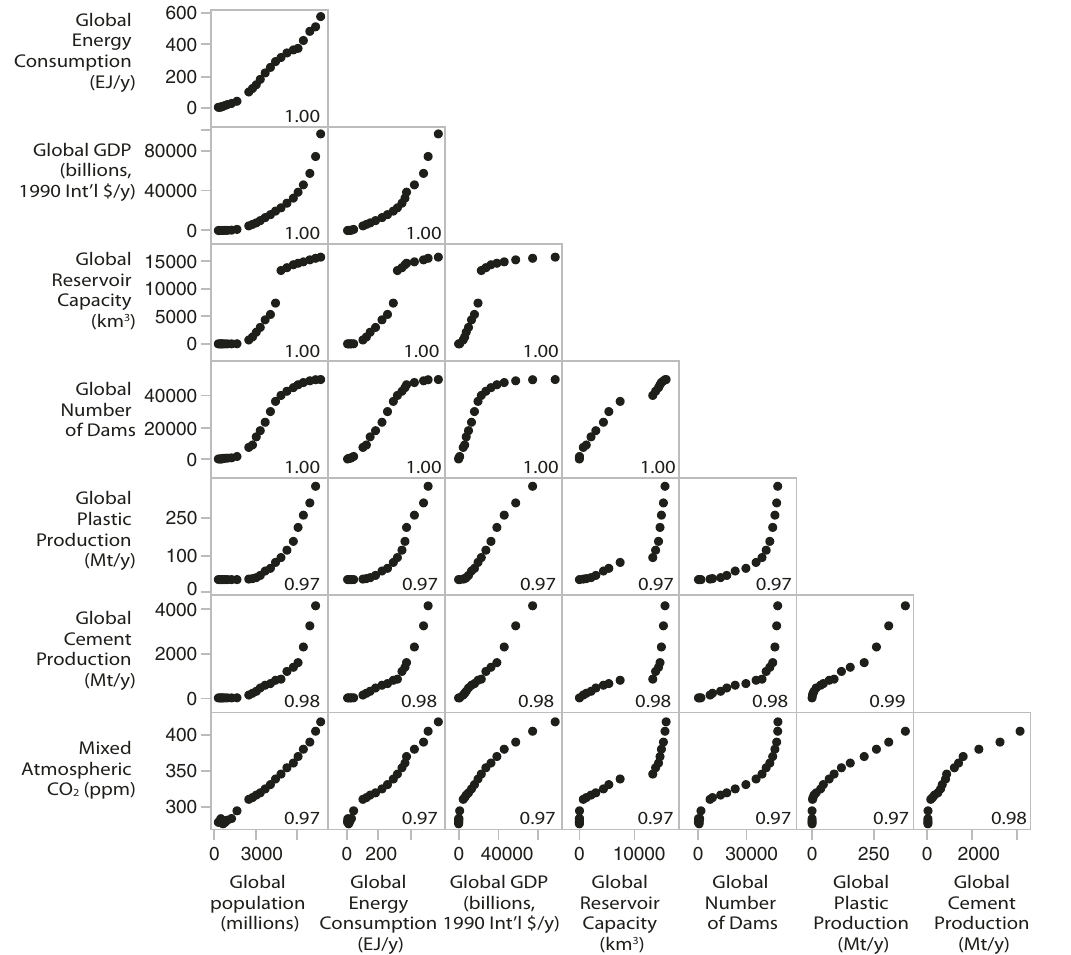
Fig. 4 Statistical relationships between human population, productivity, and energy, and key environmental indicators. Correlation-matrix displayed as cross plots for examples of Late Holocene and Anthropocene environmental factors, including ensemble estimates of global human population (millions), global human energy consumption (EJ/y), global GDP (billions, 1990 Int ’ l $/y), global reservoir capacity (km 3 ; year-end), global number of large dams (year-end), global plastic production (year-end), global cement production (year-end), mixed atmospheric CO 2 (mid-year). The value in the lower right corner of each plot identi fi es the Spearman ’ s rank-order correlation coef fi cients. Data references are listed within Supplementary Online